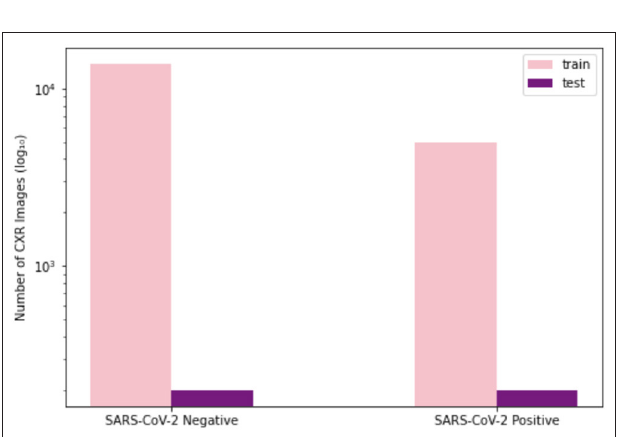
FIGURE 3 | Patient distribution of benchmark dataset for SARS-CoV-2 negative and positive cases. (Left) Number of training patients, (Right) number of test